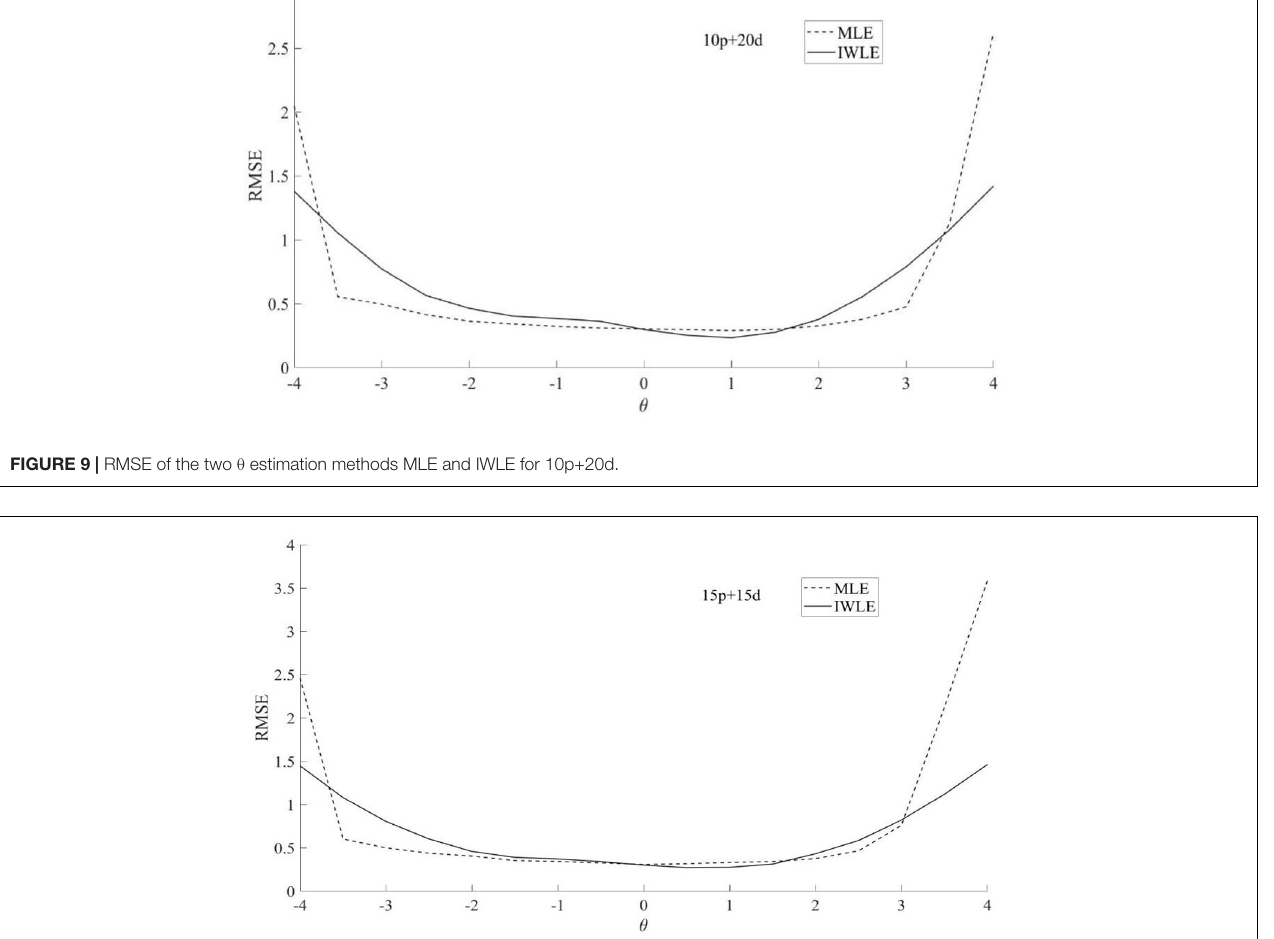
FIGURE 10 | RMSE of the two θ estimation methods MLE and IWLE for 15p+15d.